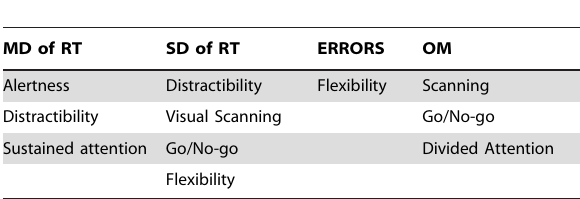
Table 3. Parameters of attentional performance in the KITAP [19,34] as indexed by the median (MD) of reaction time (RT), standard deviation (SD) of RT, error performance (ER) and omissions (OM).